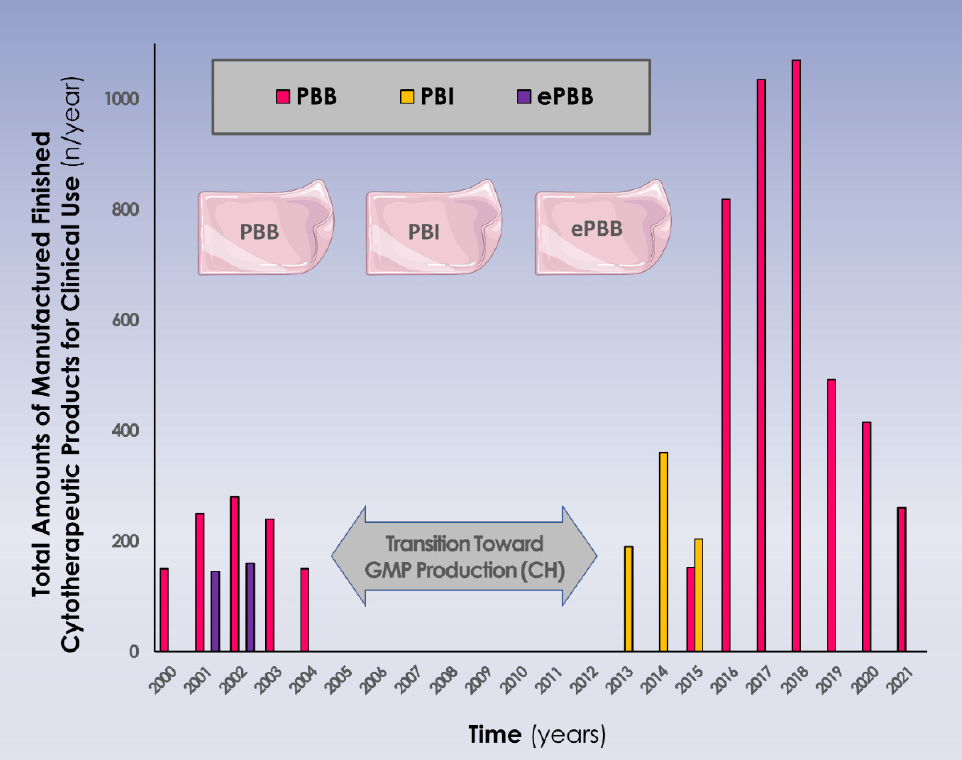
Figure 3. Evolutive overview (i.e., years 2000–2021) of the cytotherapeutic units (i.e., 9 × 12 cm constructs) manufactured for clinical applications in various pharmaceutical forms and in various therapeutic indications. It is to note that years 2020 and 2021 were impacted by the Covid-19 pandemic, with less general activity and fewer accidents occurring in the general population, resulting in reduced numbers of treated patients. Major regulatory shifts and updates occurred between 2005 and 2012, with transition for full GMP manufacturing, which marked a pause in the clinical work in Switzerland, allowing for long-term clinical follow-up work to be performed on the initial patient groups (i.e., 7–10 years of follow-up). CH, helvetic confederation; ePBB, equine progenitor biological bandage; PBI, progenitor biological bandage yielding γ -irradiated cells; PBB, progenitor biological bandage.